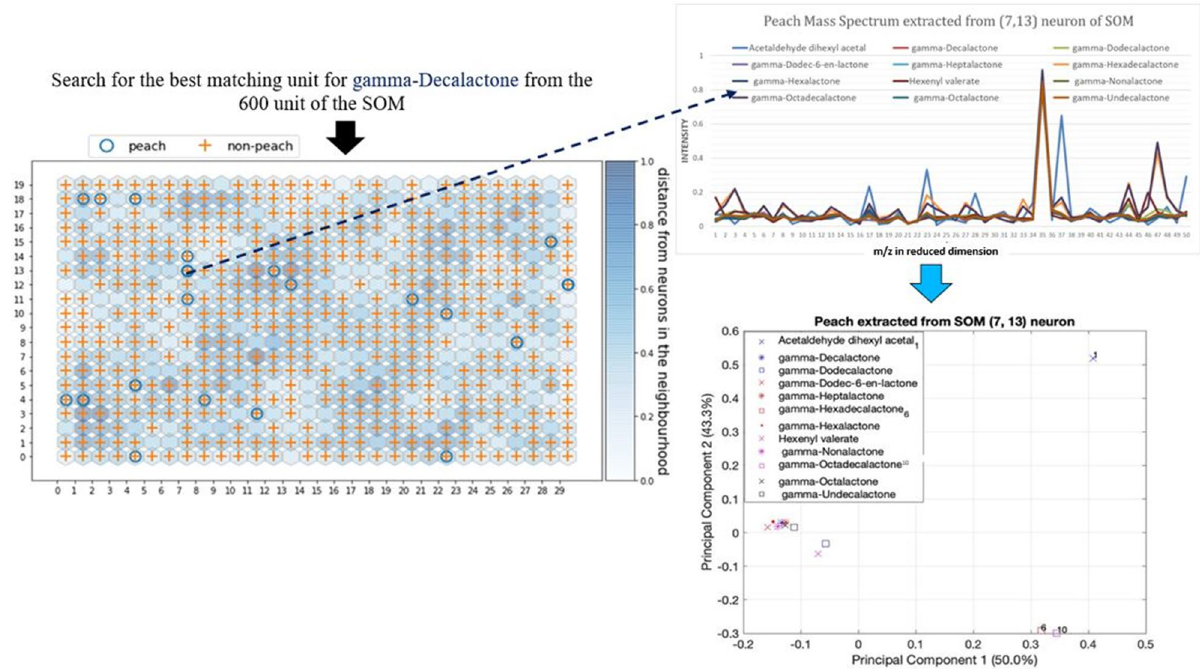
Figure 2. [Left side] Peach SOM (30*20) map. [Right side] Extract mass spectrum for ‘peach’ odor descriptor followed by Principal component analysis to check the closeness of the extracted molecules. Extracted mass spectrum dimension is same as the reduced dimension of mass spectrum from the Auto-encoder model. Horizontal axis values (1 to 50) represent the 50-dimensional m/z values from the bottleneck layer of the 5-layer